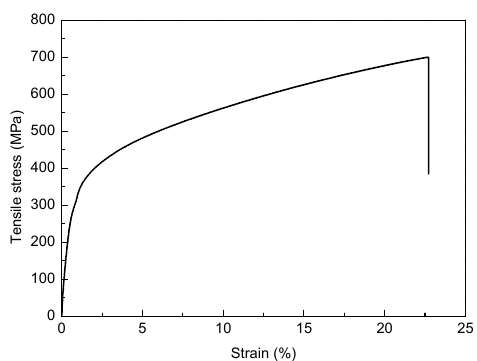
Figure 3. Typical engineering stress-strain curve of 304 stainless steel (SS) rotary friction-welding (RFW) joint (welding pressure is 40 MPa, rotation speed is 500 rpm, welding time is 9 s, and forging pressure is 200 MPa).